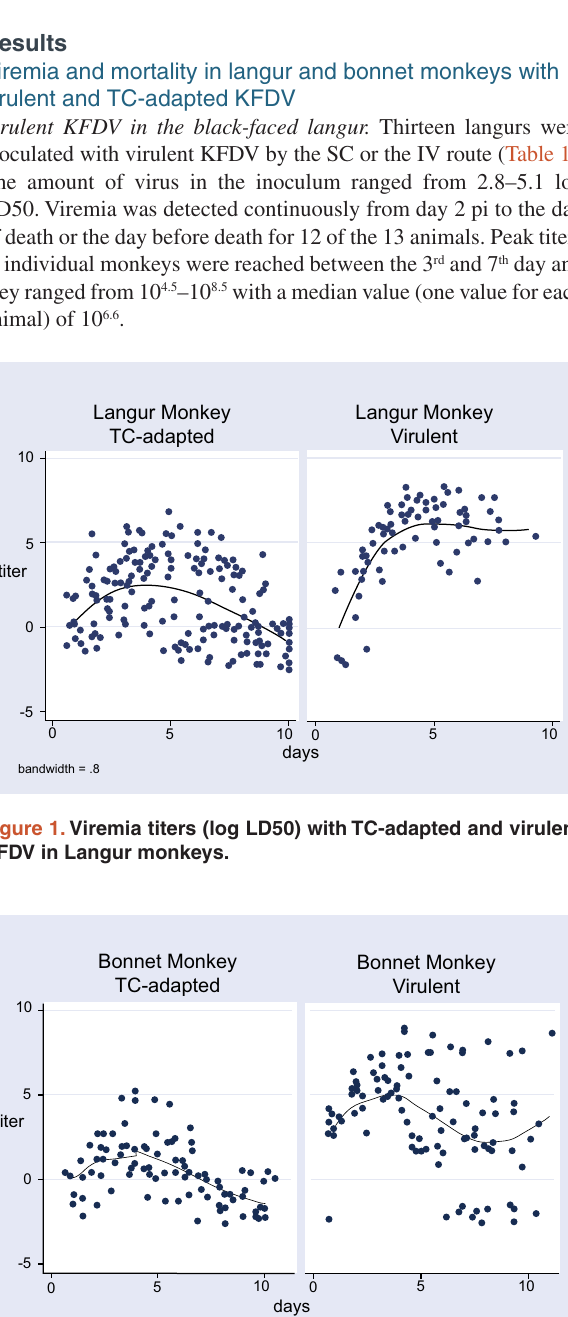
Figure 2. Viremia titers (log LD50) with TC-adapted and virulent KFDV in bonnet monkeys.